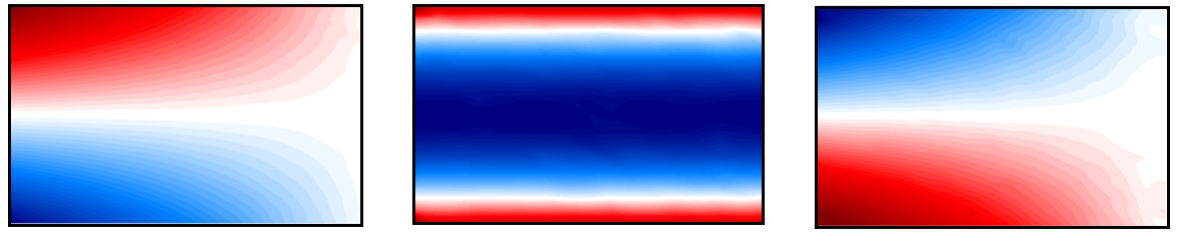
Figure 5. RBF Beam solution (Reconstructed solution ε xx , ε xy , ε yy ).